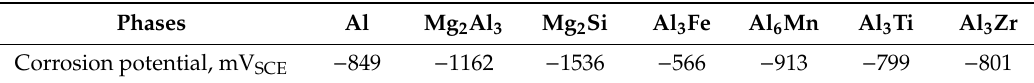
Table 2. Corrosion potential of pure aluminum and Al alloy secondary phases in 0.6 M NaCl solution